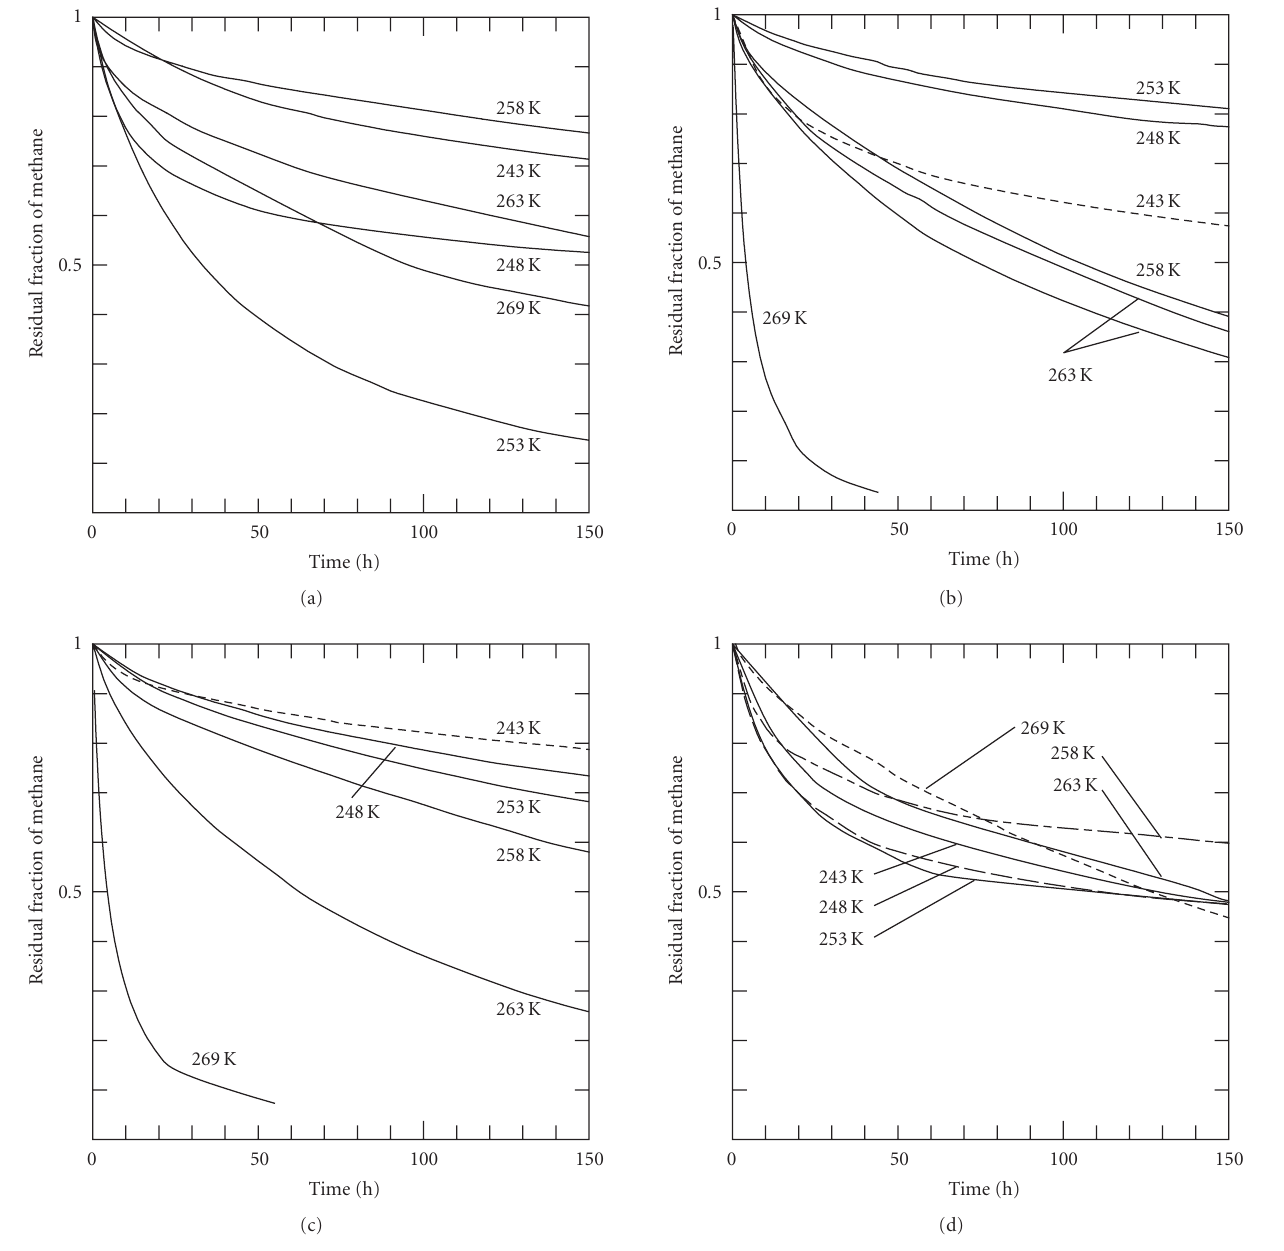
Figure 2: Decomposition behavior of methane hydrate samples prepared from various solutions. (a) Pure water. (b) 1.0 mol/m 3 aqueous sodium chloride. (c) 0.50 mol/m 3 aqueous magnesium chloride. (d) 0.50 mol/m 3 aqueous sodium